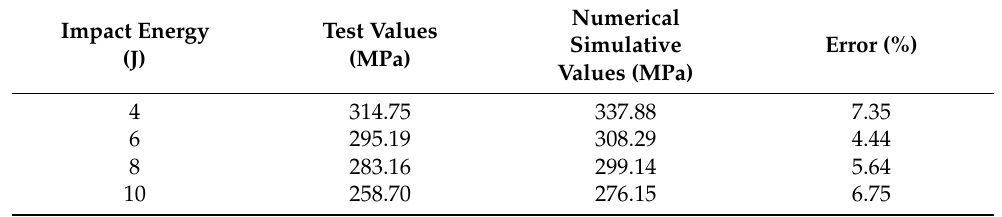
Table 6. Comparison of CAEI strength.